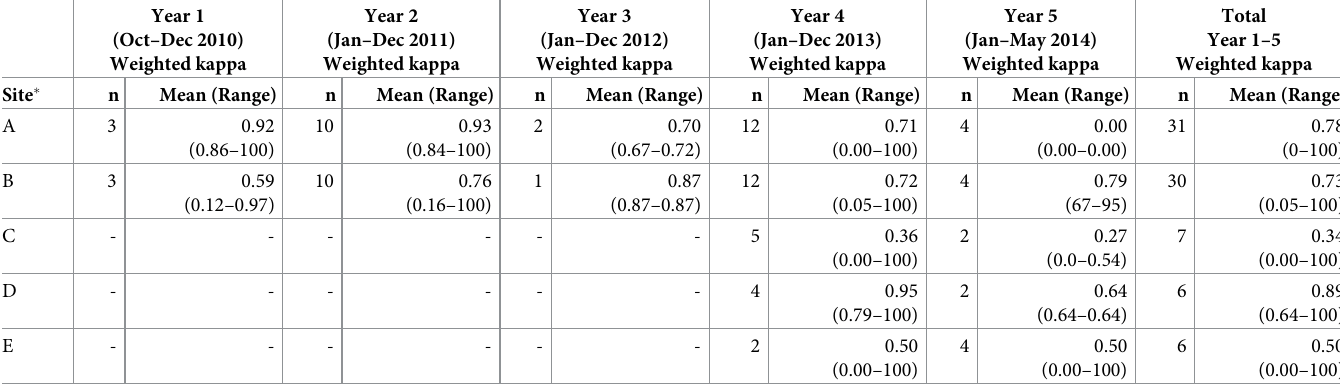
Table 3. Mean weighted kappa estimates by year and site: 2010 to